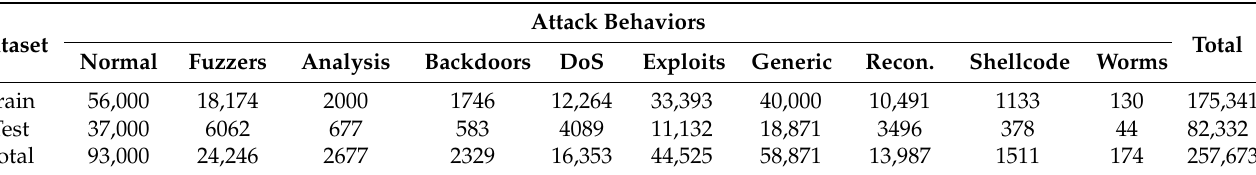
Table 4. Distribution of different attack behaviors in the UNSW_NB15 dataset.